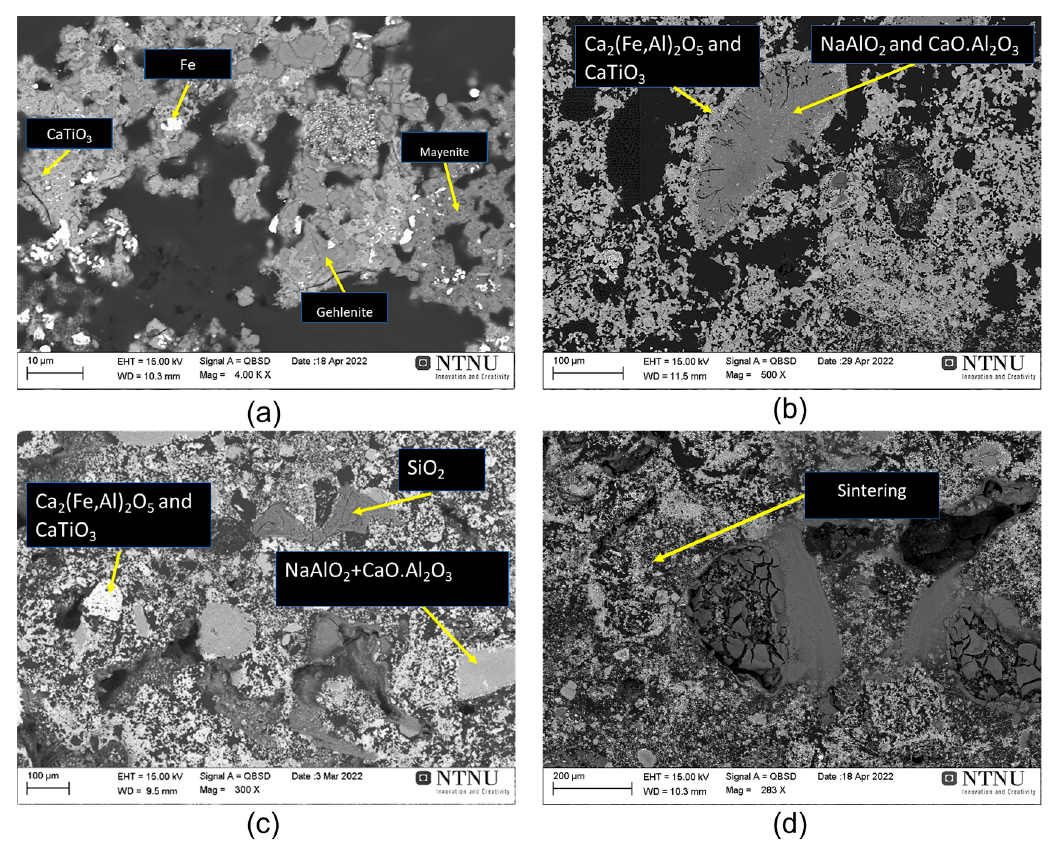
Figure 11. SEM image analysis of reduced pellets at different temperatures: 1000 °C at 4000X ( a ); 800 °C ( b ), 500 °C ( c ) and 1000 °C at 283X ( d ).